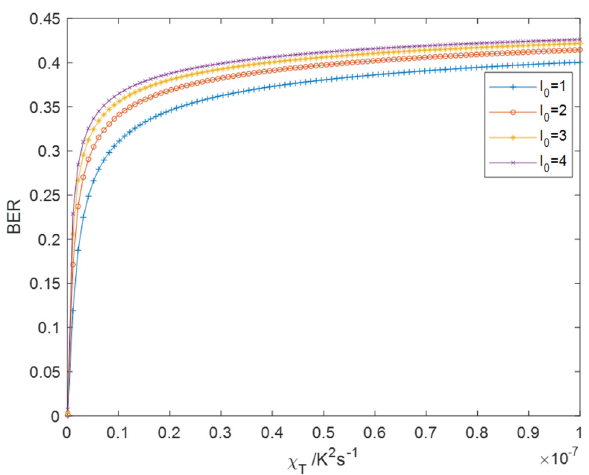
Figure 5. BER of the coaxial double-position power Gaussian vortex carrier communication link versus dissipation rate of the mean-squared temperature χ T for different topological charge of vortex.